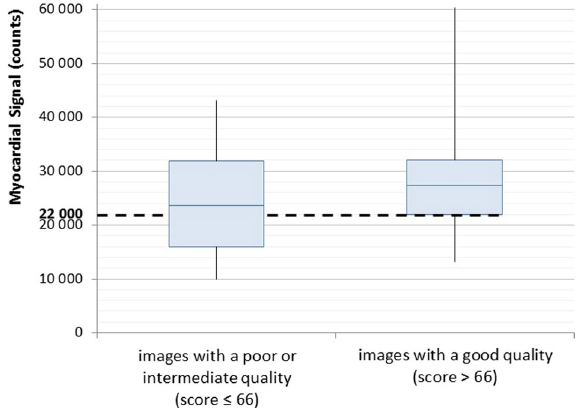
Fig. 5 Box plot showing the myocardial‑signal distributions in the poor‑/intermediate‑ and good‑quality images. The myocardial signal at the first quartile of the good‑quality images was 22,000 counts. It was chosen as the myocardial signal